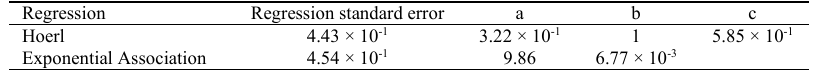
Regression Regression standard error